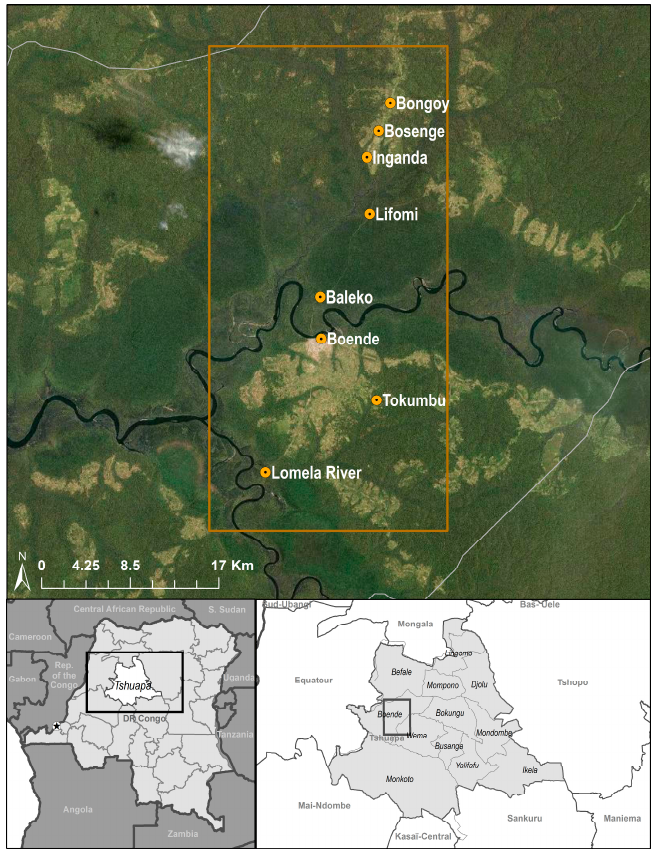
Figure 1. The location of the collection sites is indicated by the orange circles in the top figure. The orange rectangle indicates the area used to extract principal component values. Bottom figures indicate the location of Tshuapa Province ( left ) and the 12 health zones within the province ( right ).